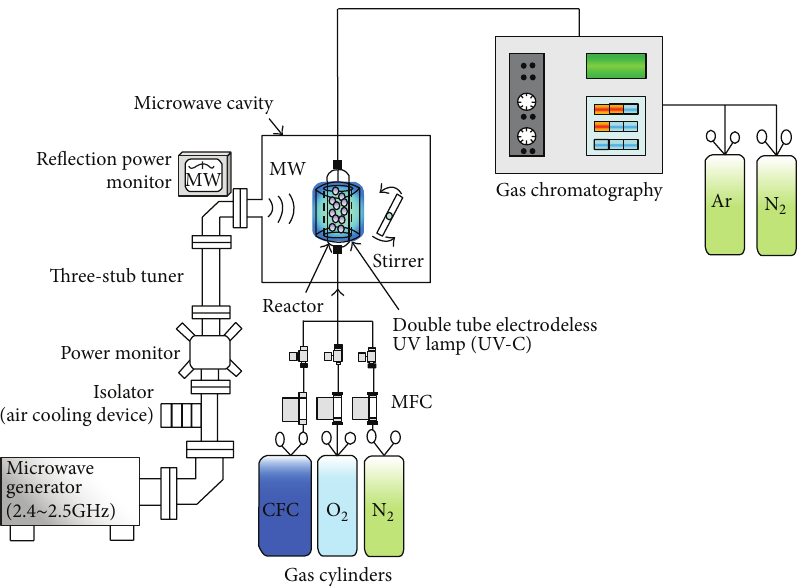
Figure 1: The schematic of microwave/UV/TiO 2 photocatalysts hybrid